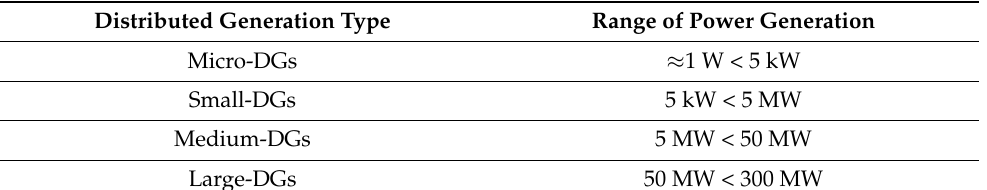
Table 3. DG technology based on size.